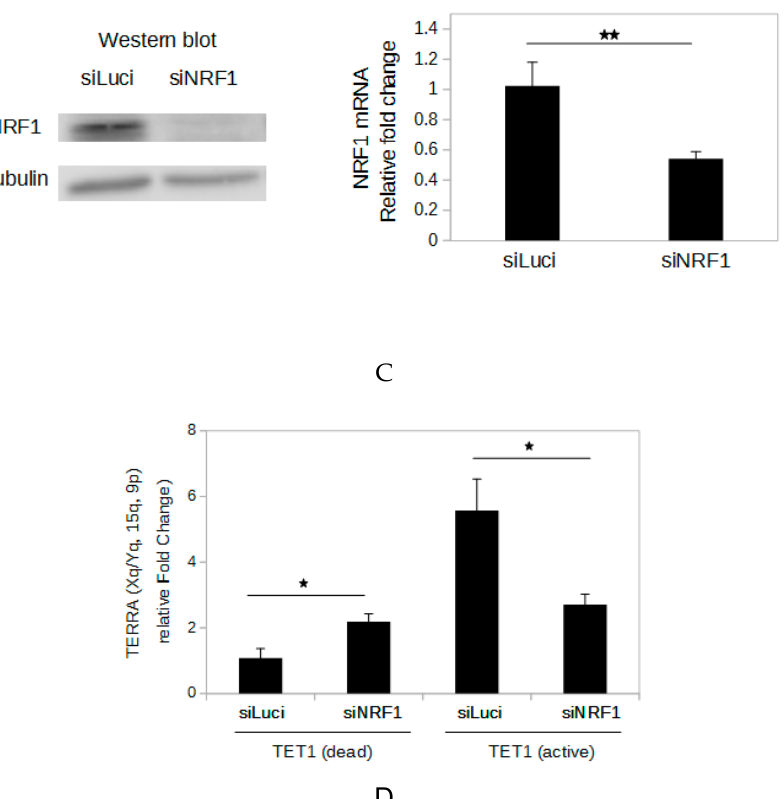
Figure 3. NRF1 (nuclear respiratory factor 1) binding to subtelomeres is involved in DNA methylation-dependent regulation of TERRA expression. ( A ) Chromatin immunoprecipitation (ChIP) assays were performed using chromatin extracted from HeLa cells untreated (NT) or treated with 10 µ M 5-aza-dC (5aza) for 72 h and an antibody that recognizes NRF1 (ab-NRF1) or a non-specific antibody (IgG). Primers specific for subtelomeres Xq, Yq, 15q, 16p, and 9p (ChIP-F / ChIP-R), the promoter region of the TFB2M (transcription factor B2 of the mitochondria) gene (TFB2M-F / TFB2M-R), or a region of the 36B4 gene devoid of NRF1 binding sites (36B4-F / 36B4-R) were used to detect co-precipitated chromatin fragments. For each condition (untreated and 5-aza-dC-treated), three biological replicates were used for the ChIP assay. Each lane corresponds to a biological replicate. Values above the gel correspond to the average signal intensity normalized to the Input of untreated cells. Ladder is the 50 bp DNA ladder (New England BioLabs). ( B ) HeLa cells were untreated ( − ) or treated ( + ) with 10 µ M 5-aza-dC (5aza) for 72 h. Left , Western blot analysis of NRF1 protein. Tubulin was used as a loading control; 30 µ g of total protein was loaded in each well. Right , RT-qPCR analysis of NRF1 mRNA. Levels were normalized to GAPDH mRNA, and all values were compared to untreated cells. ( C ) HeLa cells were lipofected with small interfering RNAs (siRNAs) targeting NRF1 (siNRF1) or a control siRNA targeting luciferase (siLuci). Lipofections were performed at days 1 and 2, and proteins and RNA were extracted at day 3. Left , Western blot analysis of NRF1 protein. Tubulin was used as a loading control; 30 µ g of total protein was loaded in each well. Right , RT-qPCR analysis of the NRF1 mRNA. Levels were normalized to GAPDH mRNA, and all values were compared to cells lipofected with siLuci. ( D ) RT-qPCR analysis of TERRA produced from Xq, Yq, 15q, and 9p in HeLa cells transfected with the CRISPR-dCas9-TET1 system (TET1 active or dead) and subtelomeric gRNAs then lipofected with siNRF1 or siLuci. Transfection was performed at day 0, lipofections were performed at days 1 and 2, and RNA was extracted at day 3. TERRA was quantified by RT-qPCR using TR and TF; levels were normalized to GAPDH mRNA, and all values were compared to the samples transfected with catalytically dead TET1 and lipofected with siLuci. The bars represent the average values from three biological and two technical replicates for each sample. Error bars represent the standard deviations. p values were calculated by paired two-tailed Student’s t-test ( n = 3). * p < 0.05. ** p < 0.01. NS: not significant ( p > 0.05).